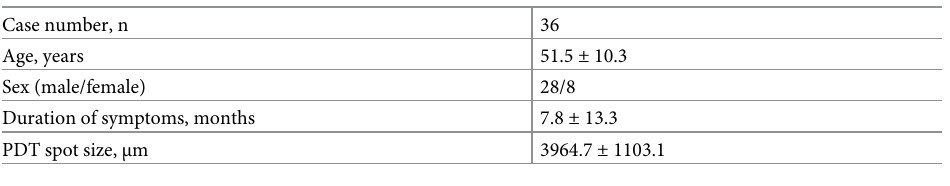
Table 1. Clinical characteristics.